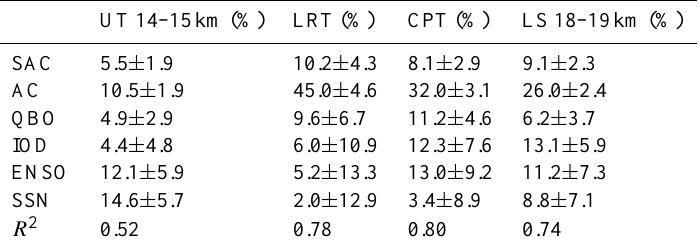
Table 2. Contribution and corresponding standard deviations (in percentages) of SAC, AC, QBO, IOD, ENSO and 11-year solar cycle to temperature variability at UT (14–15km), LRT, CPT and in the LS (18–19km), as obtained by the linear regression Trend-Run model. The last line gives the corresponding values for the coefficient of determination, R 2 .